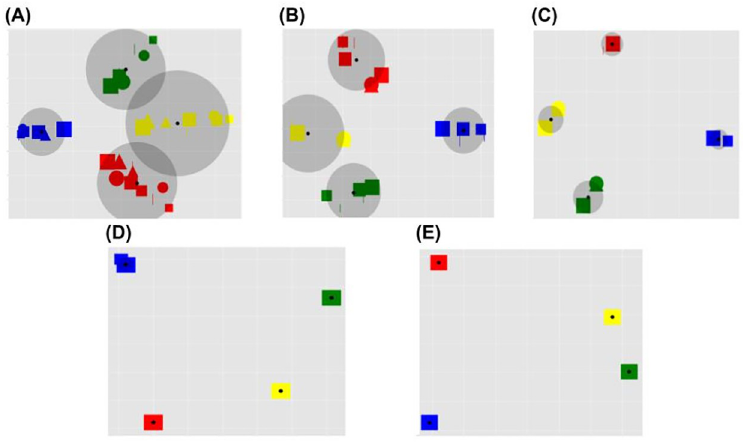
Fig 7. Colour sorting category: Reconstructed input. Principal components of the reconstructed image representations in the case of the colour sorting rule and in correspondence to different levels of RL (shown in different graphs). The dimensionality of the reconstructed image was reduced to two through a PCA (x-axis: first component; y-axis: second component). Within each graph, each reconstructed image is represented by a point marked by an icon that summarises the colour, shape, and size of the shape in the image (some icons are not visible as they overlap). The centroids of the four clusters found by the K-means algorithm are marked with a black dot, while the maximum distance of the points of the cluster from its centroid is shown by a grey circle. A: Level 0 (L0), absent RL (only UL); B: Level 1 (L1), low RL; C: Level 2 (L2), moderate RL; D: Level 3 (L3), high RL; E: Level 4 (L4), extreme RL (no